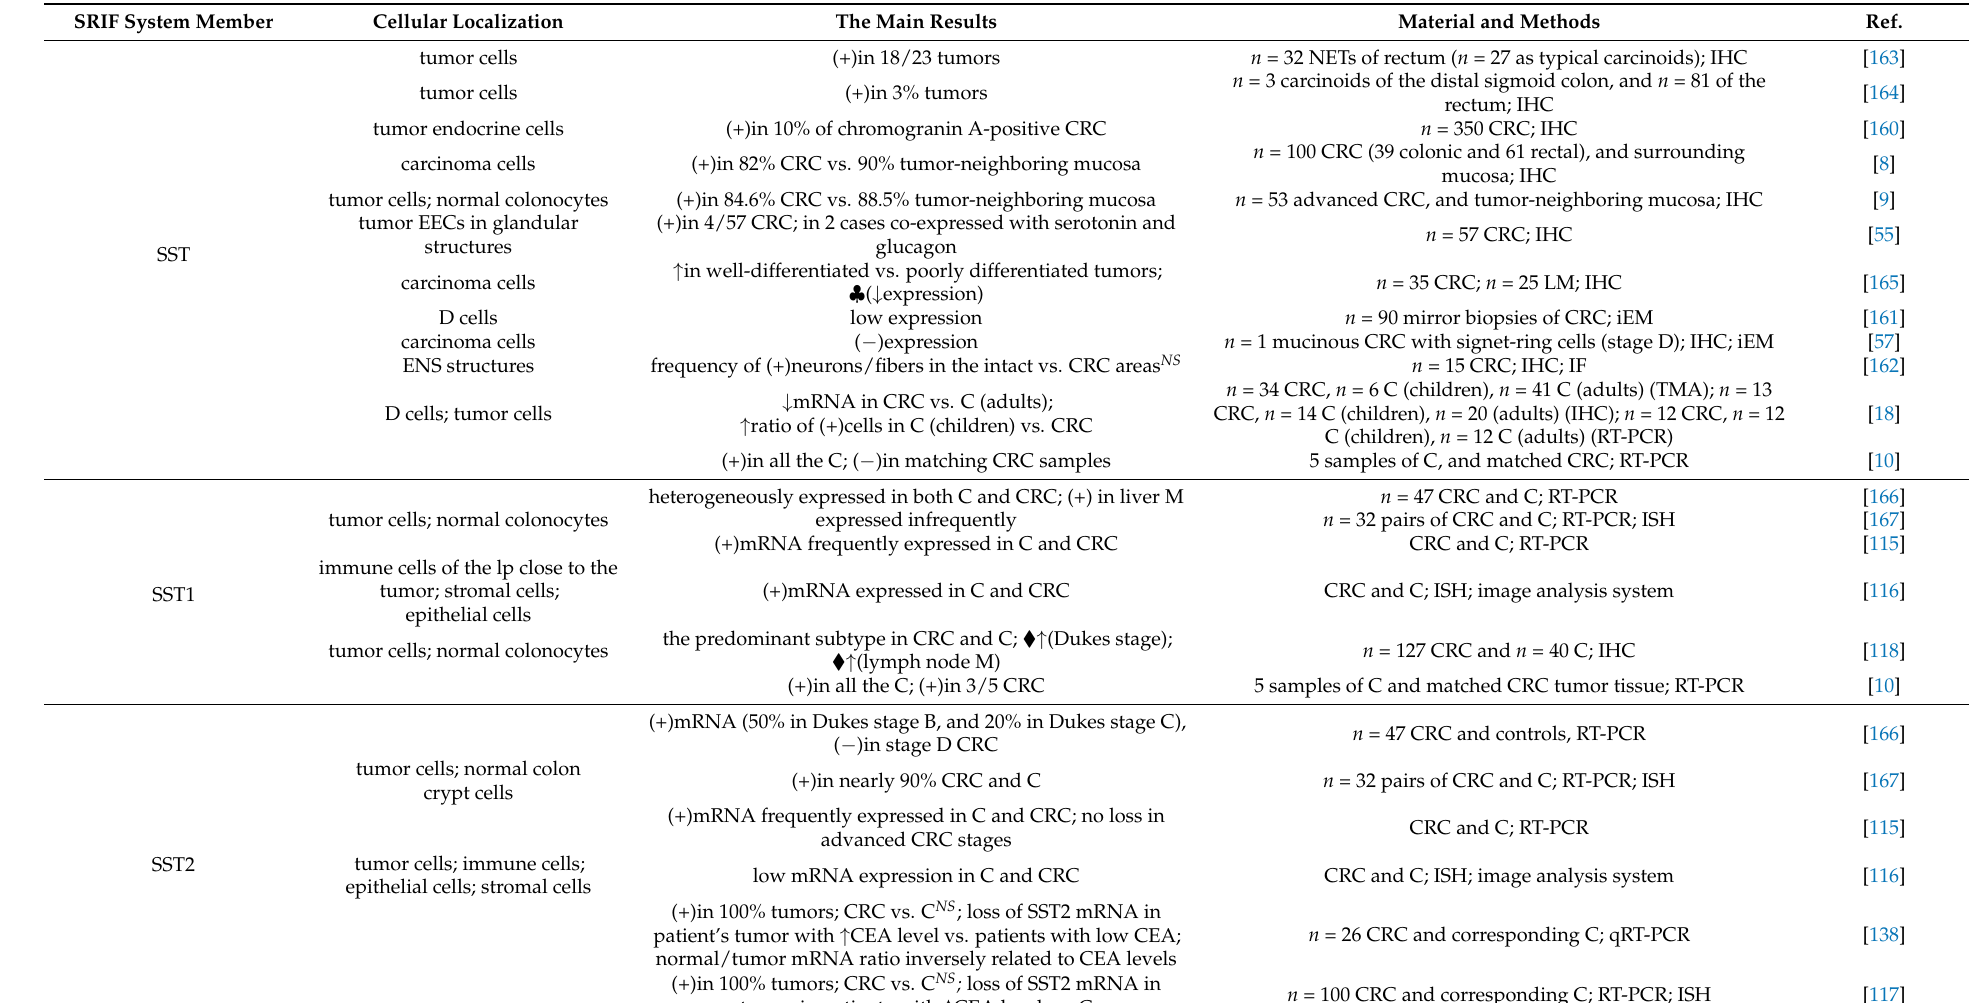
Table 2. Tissue expression of somatostatin (SST) and its receptors (SST1–5) in different subtypes of colorectal cancer